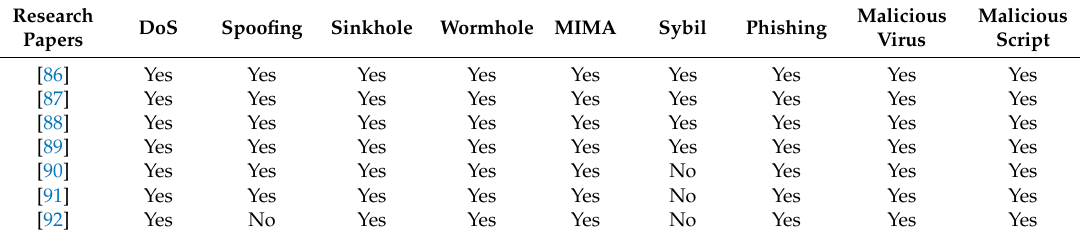
Table 6. Attacks on asymmetric based encryption